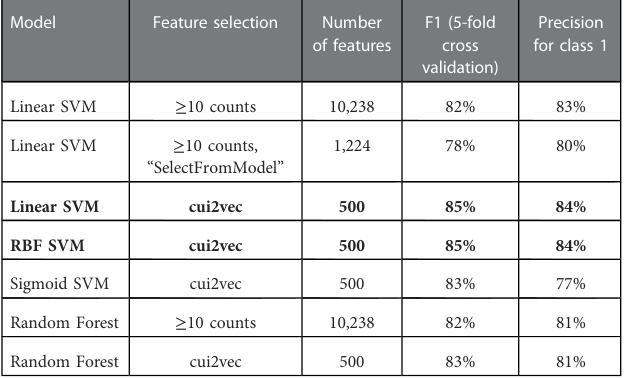
TABLE 4 Models to classify